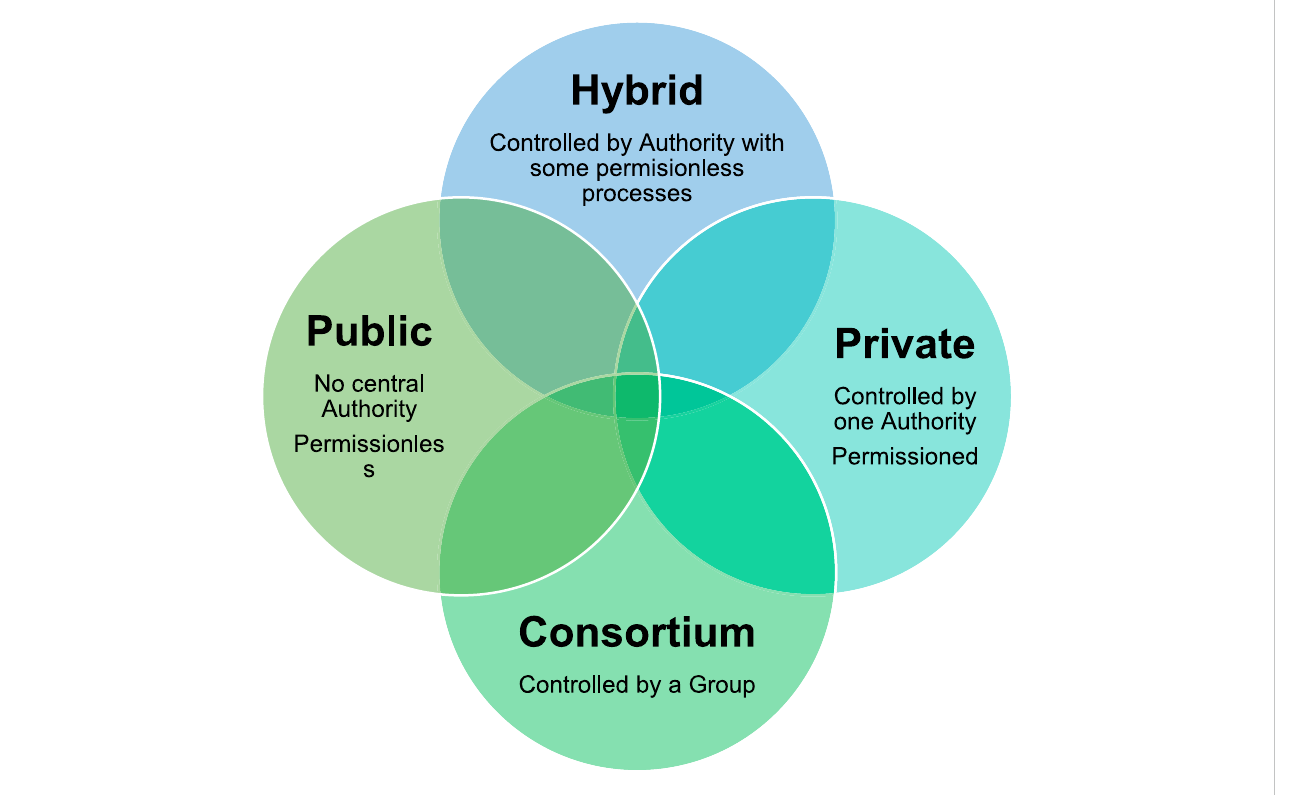
FIGURE 3 Figure 2 Types of blockchain. According to Anderberg et al. (2019) blockchain technology has two types namely: public and private, which are further divided into permissioned and permissionless subtypes.